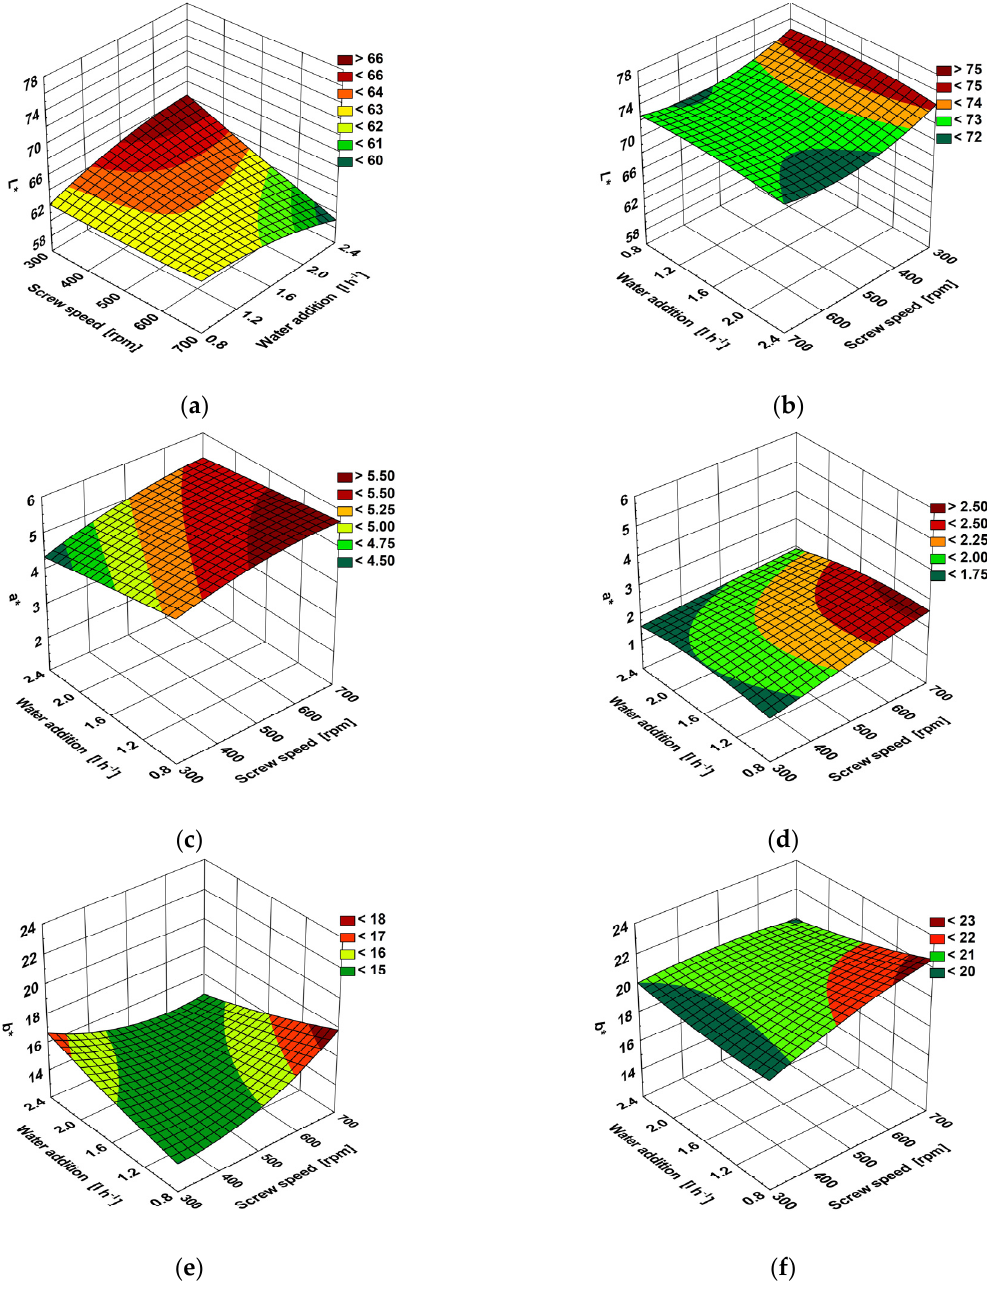
Figure 4. Effect of various extrusion parameters on lightness ( L* ) and colour components (redness a* and yellowness b* ) of the extruded red beans ( a , c , e ) and white beans ( b , d , f ). Aura bean was the brighter with the higher L* values in comparison with Toska bean.